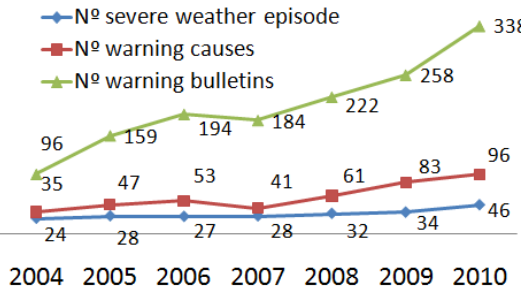
Figure 5. Number of severe weather episodes related with warning causes and number of bulletins by year, for 2004–2010 period. 3